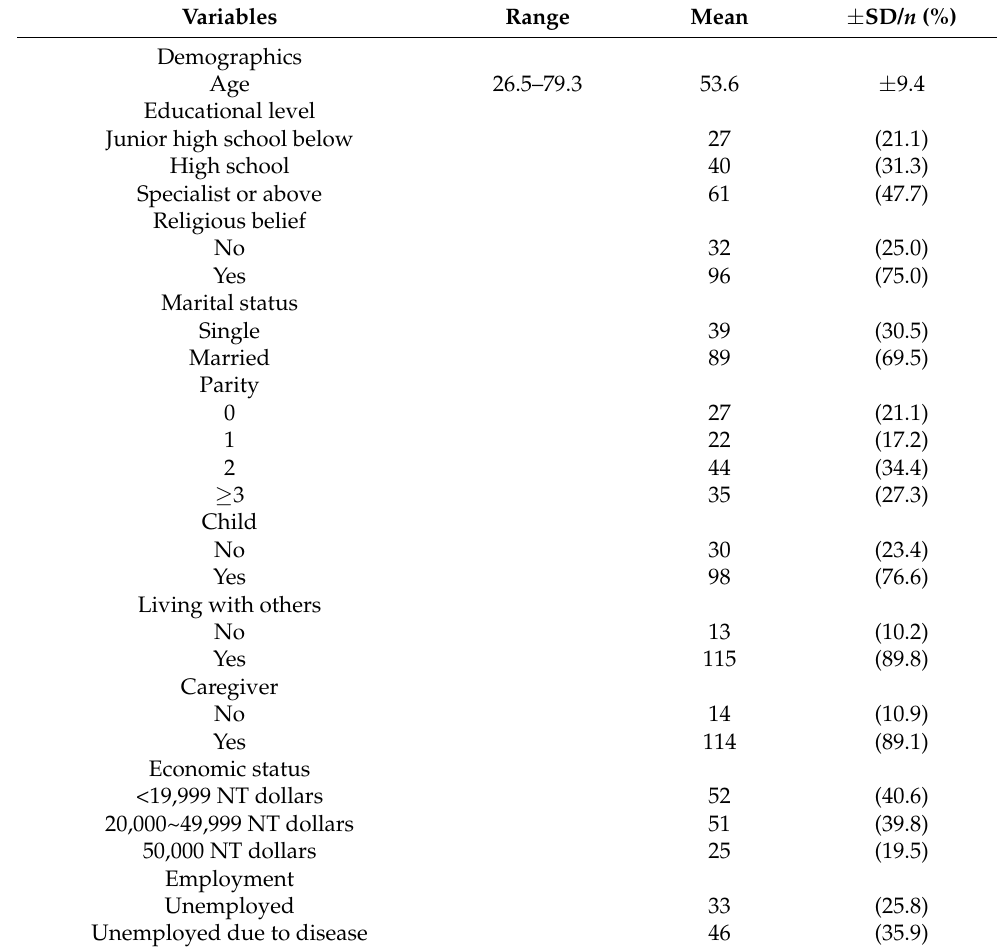
Table 1. Characteristics of demographics, disease-related, and treatment among patients with breast cancer ( n =